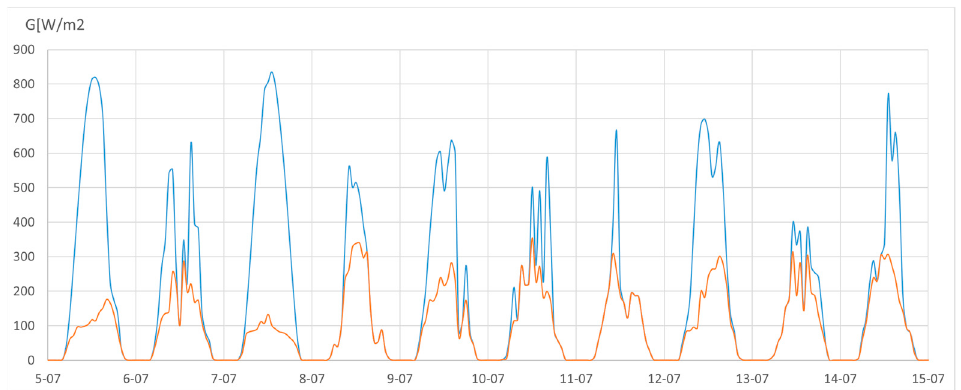
Figure 1. Examples of total (blue) and diffuse (orange) irradiance waveforms for Warsaw .